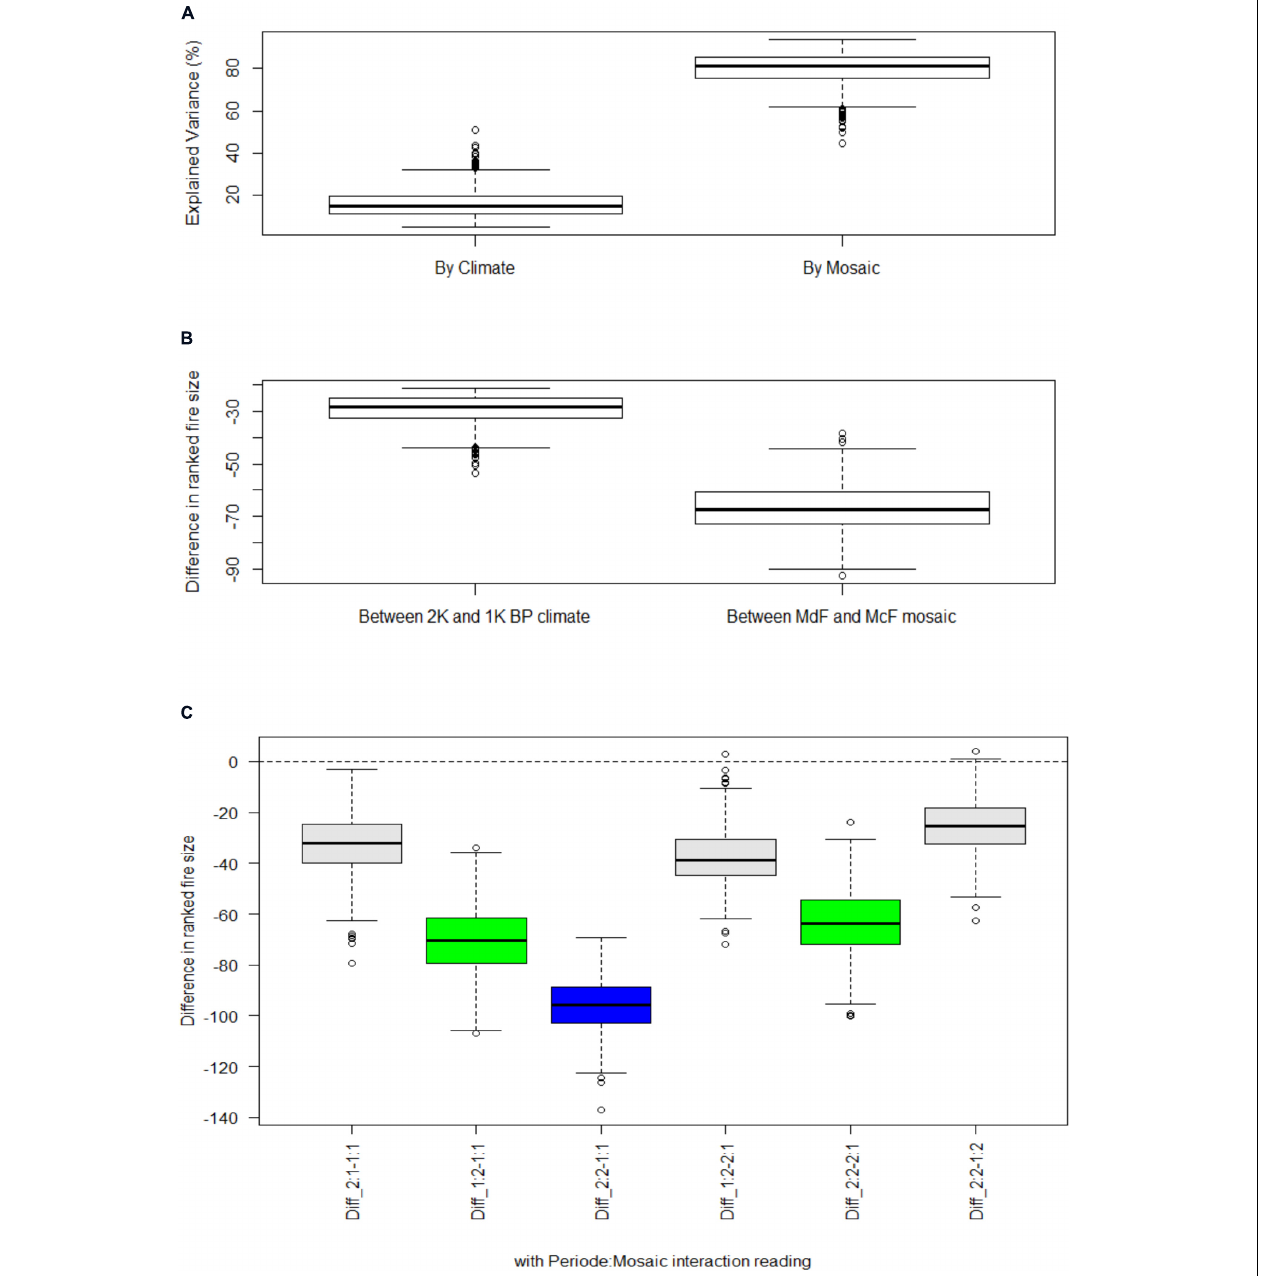
FIGURE 5 | Results of the significant two-way ANOVA encompassing the 2K–1K BP millennium changeovers. (A,B) refer to the 55% of ANOVAs for which both Climate and Mosaic had significant (additive) effects, with the variance partition between factors (A) and the differences in fire sizes between levels of a given factor (TukeyHSD test, B ). For the few ANOVAs in which the Climate:Mosaic interaction was significant (C) , McF is coded 1 and MdF is coded 2. Among the six pairs of differences in fire sizes analyzed using the TukeyHSD test, the most significant and important difference was found for the change from the 2K BP MdF mosaic to the 1K BP McF mosaic (blue boxplot), which represented palynological changes. The two green boxplots are representative of differences found in the first two series (see Supplementary Figures S6,S7 ), but only for 2K–1K BP differences.